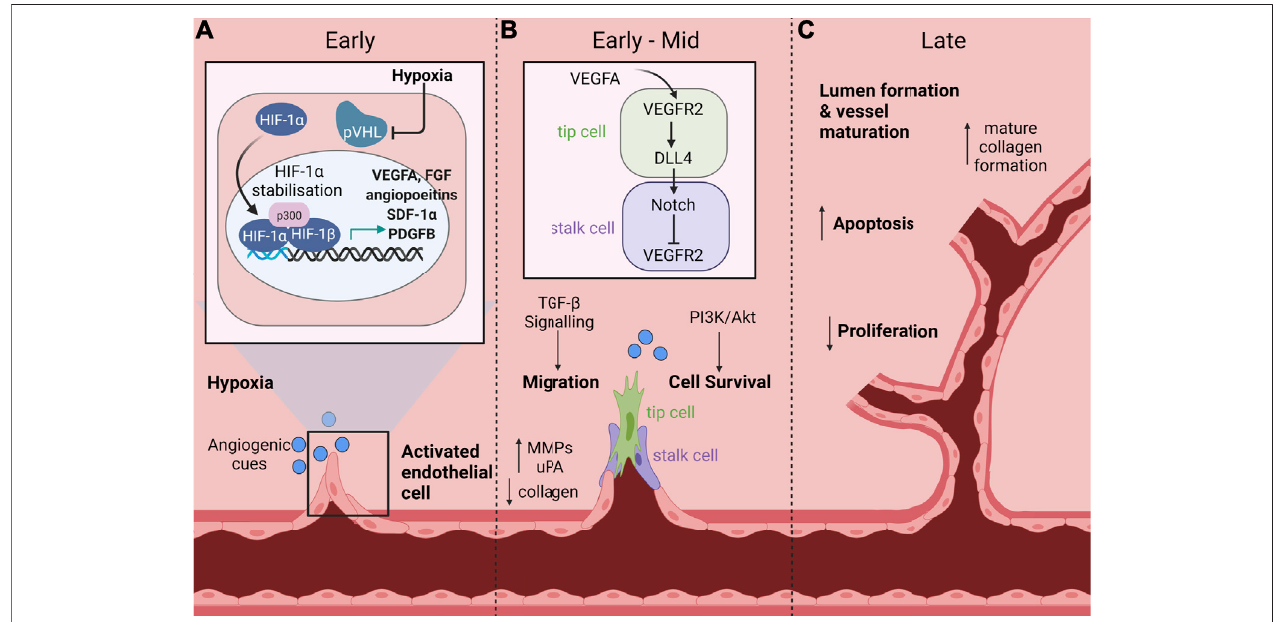
FIGURE 1 | Signaling pathways and cellular processes that mediate ischaemia-driven angiogenesis. Ischaemia-driven angiogenesis involves several processes thatworkinatransientandoverlappingfashiontoallownewbloodvesselformation. (A) Early:Endothelialcells(EC)becomeactivatedinresponsetoanischaemicinjury. Under hypoxic conditions, the master regulator hypoxia inducible factor-1 α (HIF-1 α ) is stabilised and protected from ubiquitin labelling by the von Hippel-Lindau (VHL) complex,preventingsubsequentdegradation.ThisallowsHIF-1 α toaccumulateandtranslocatetothenucleuswhereitassociateswithHIF-1 β .TheHIF-1 α /HIF-1 β complex then binds to hypoxia response elements to induce the transcription of pro-angiogenic mediators including vascular endothelial growth factor A (VEGFA), fi broblast growth factor (FGF), angiopoietins, stromal cell derived factor-1 α (SDF-1 α ) and platelet derived growth factor B (PDGFB). (B) Early-Mid: EC activation reduces theexpressionofcollagenandincreasestheexpressionofproteolyticenzymessuchasmatrixmetalloproteinases(MMPS),whichpromotedegradationofthebasement membrane and dissolution of adherent junctions that allow invasion of cells into the surrounding interstitial matrix. ECs are then speci fi ed into tip and stalk cells, which is controlled by Notch signaling. VEGFA stimulates tip cell induction and fi lipodia formation via VEGFR2, which promotes increased expression of the Notch ligand, delta- like ligand 4 (DLL4) in tip cells. Conversely, in adjacent cells, DLL4 promotes downregulation of VEGFR2, mediating a highly speci fi ed negative feedback loop between VEGFA and Notch to regulate tip and stalk cell formation. Additional signaling pathways including transforming growth factor- β (TGF- β ) and phosphoinositide 3-kinase (PI3K)/Akt are activated to promote endothelial cell migration and survival respectively. (C) Late: As the lumen of the new vessel begins to form and the vessel matures, there is an increase in apoptosis and decrease in proliferation concomitant with an increase in mature collagen deposition. Created with BioRender.com.